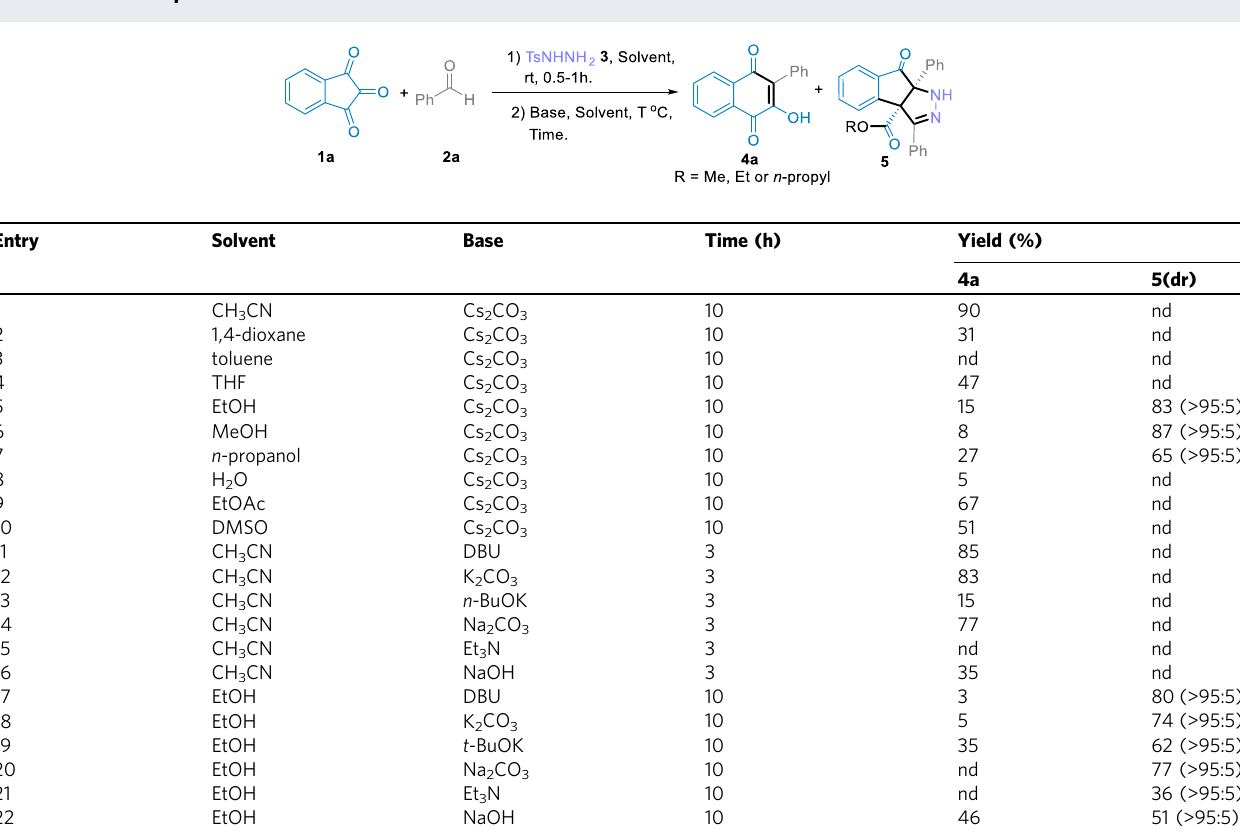
Table 1 Reaction optimization a,b,c